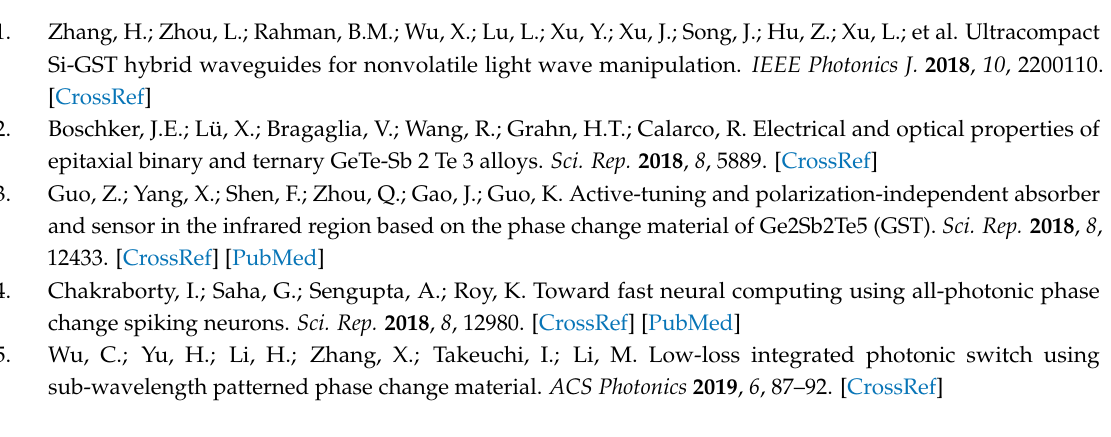
Supplementary Materials: The following supporting information including a detailed description of experimental procedures, additional tables and supporting figures is available online at http://www.mdpi.com/2076-3417/9/